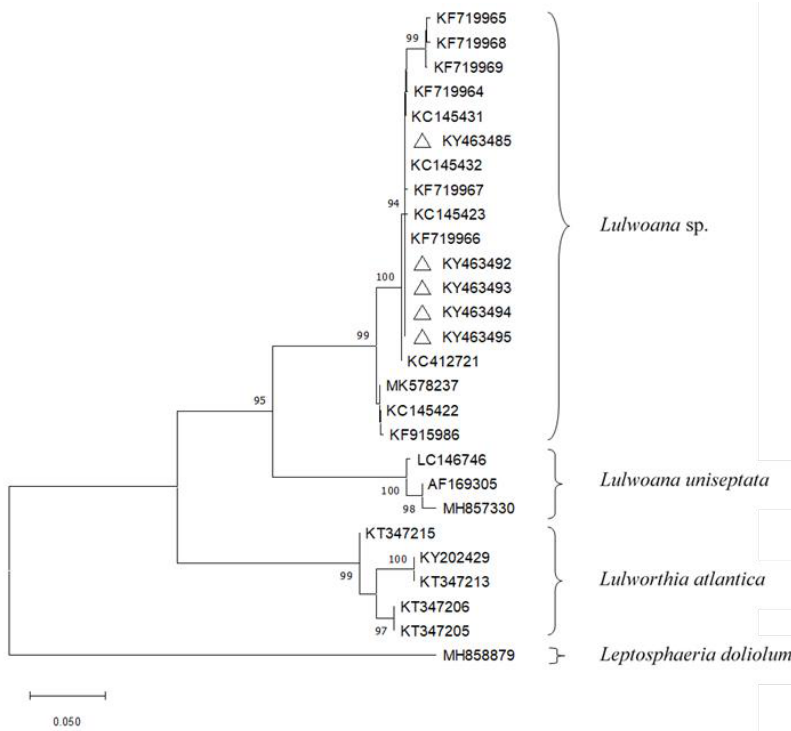
Figure 1. Neighbour-joining tree based on phylogenetic analysis of the ITS1-5.8S rDNA-ITS2 se- quences of Lulworthiales . Bootstrap percentages calculated from 1000 re-samplings are indicated at nodes. GenBank numbers with triangles represent the sequences obtained in this study and deposited at the GenBank Database.